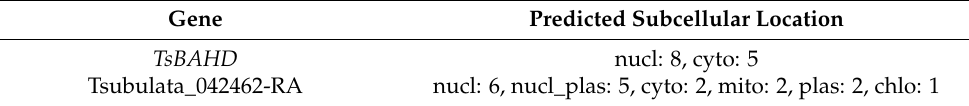
Table 1. WoLF PSORT predicted subcellular location of TsBAHD and its paralog. Gene